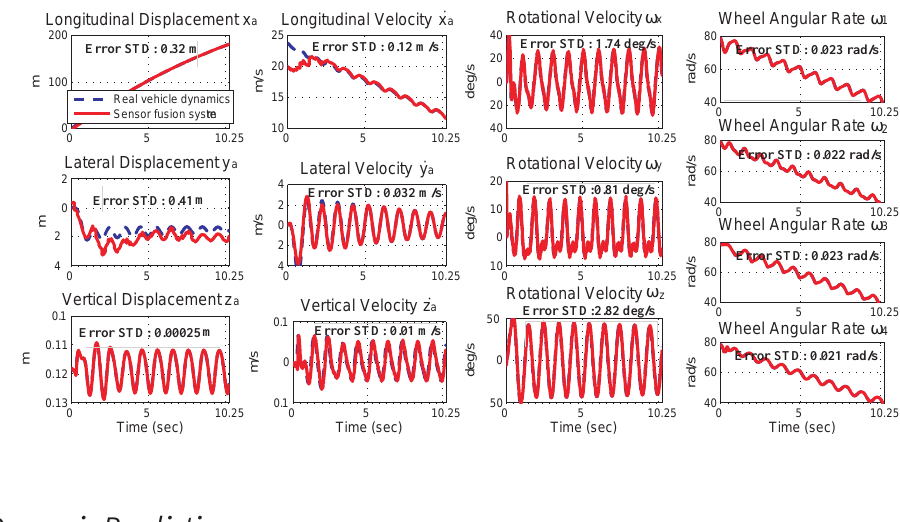
Figure 5. Comparisons of the vehicle dynamics from the simulated vehicle dynamics and the sensor fusion system outputs. The vehicle dynamics are presented in the